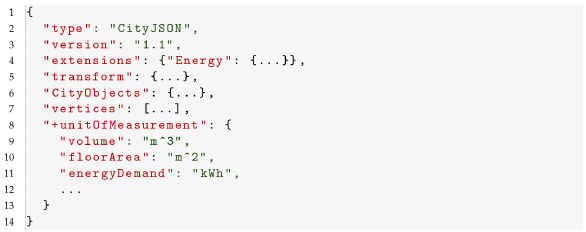
Figure 12. Definition of a root property to specify the used